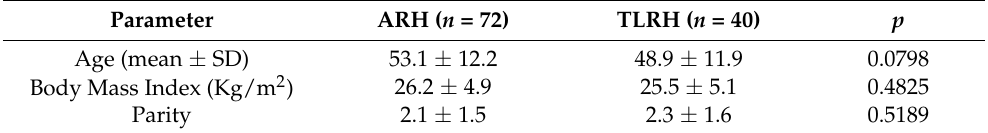
Table 2. Demographic characteristics of women who underwent abdominal radical hysterectomy (ARH) and total laparoscopic radical hysterectomy (TLRH) for cervical cancer. Parameter ARH ( n = 72) TLRH ( n = 40) p Age (mean ± SD) 53.1 ± 12.2